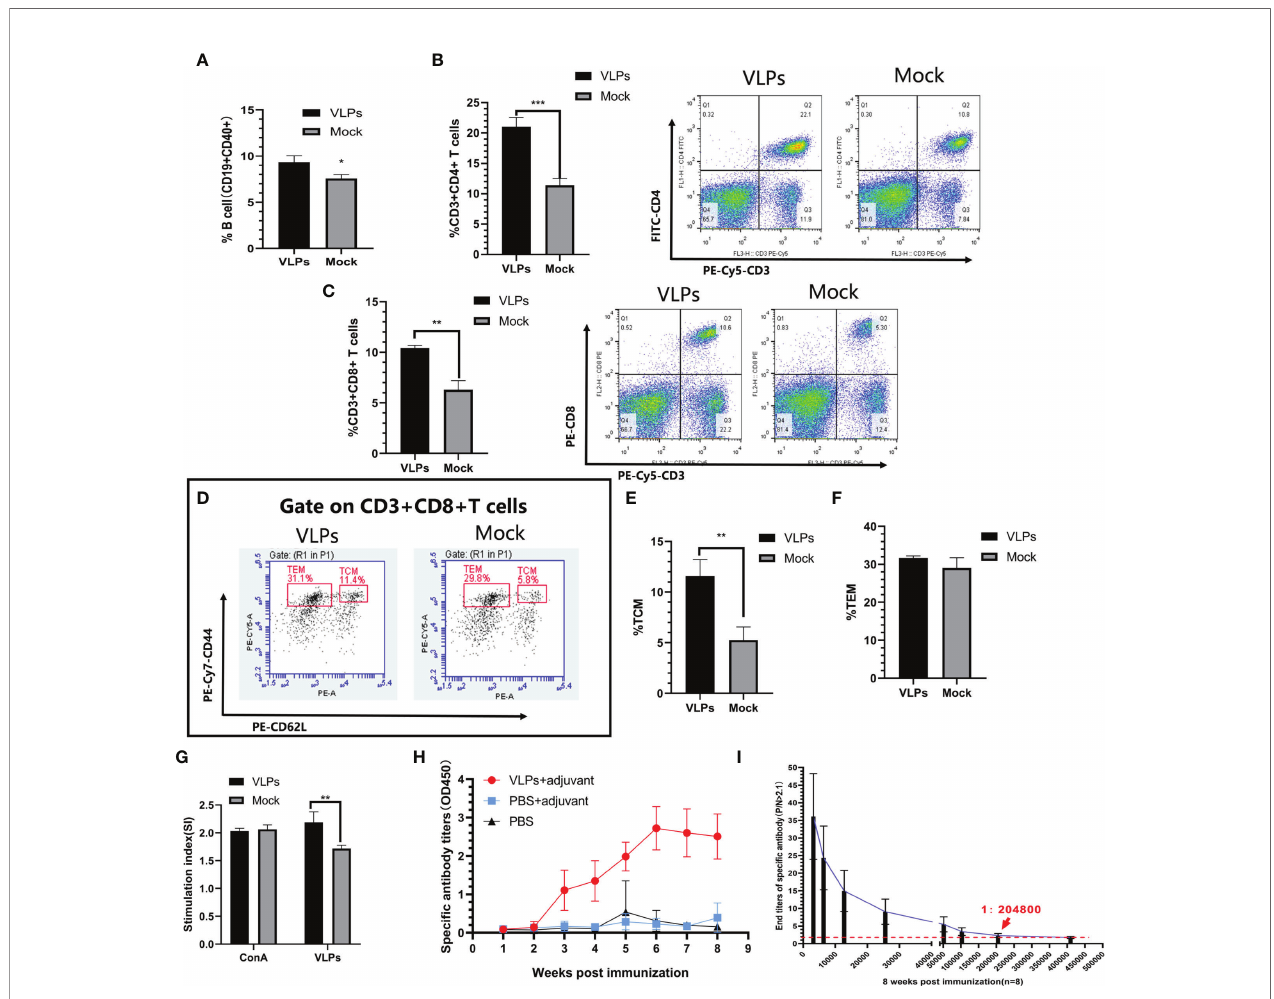
FIGURE 3 | Evaluation of immune responses in VLP-immunized mice. Splenic lymphocytes were isolated from VLP or Mock immunized mice on the 28th day after the fi rst immunization and analyzed by fl ow cytometry. B cell activation was measured as the percentage of CD19+CD40+ cells (A) . Percentage of CD3+CD4+ T cells (B) and CD3+CD8+T cells (C) . Gating strategy to detect CD8+ central memory T cells (TCM: CD3+CD8+CD44+CD62L+) and CD8+ effector memory T cells (TEM: CD3+CD8+CD44+CD62L-) (D) . Percentages of TCM (E) and TEM (F) calculated from (D) . T lymphocyte proliferation detection (G) . Weekly analysis of norovirus-speci fi c antibodies in serum after another new batch of mice was immunized with puri fi ed VLPs and adjuvant, PBS and adjuvant or PBS alone (H) . Titration analysis of norovirus-speci fi c antibody levels in sera from the VLP-immunized mice collected at 8 weeks post-immunization (I) . All experiments were performed independently at least thrice and results were presented as means ± standard deviation. Signi fi cance levels were de fi ned as *p < 0.05, **p < 0.01 and ***p <